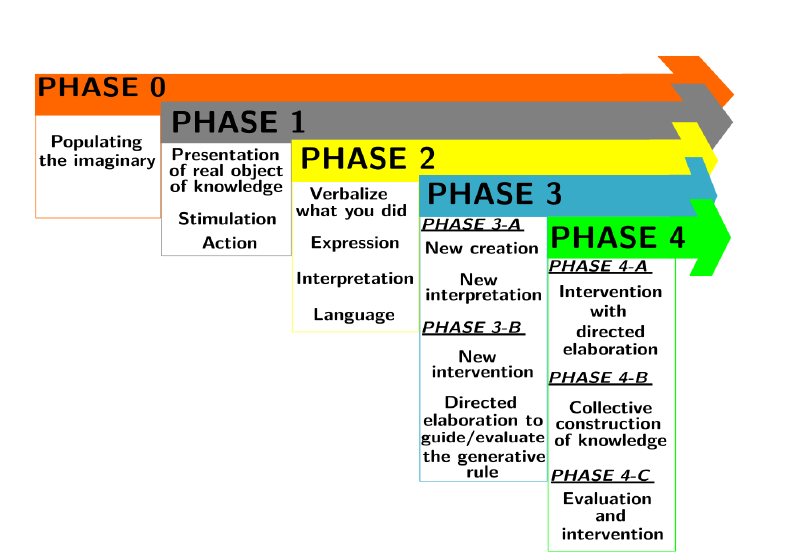
Figure 1 - Pedagogical process based on Systems Engineering